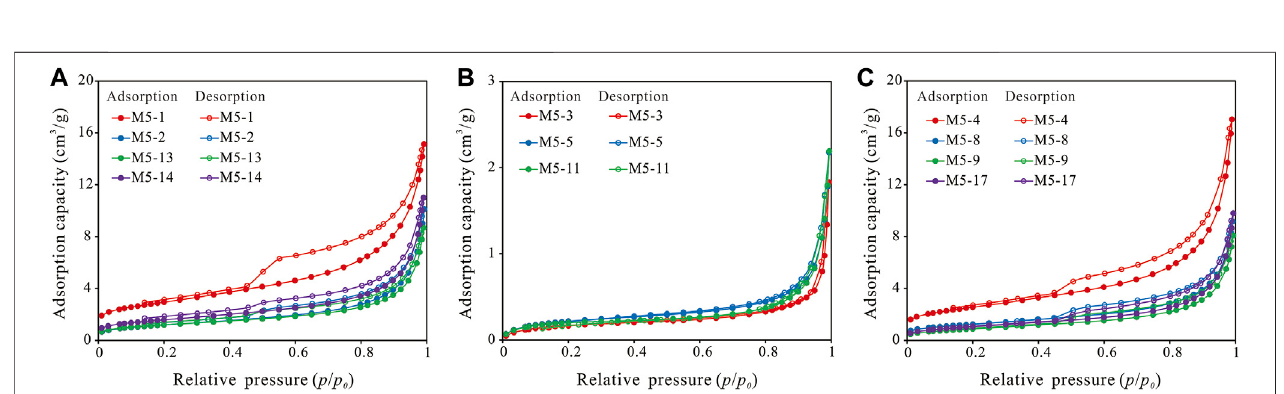
FIGURE 6 | N 2 adsorption curves of different samples. (A) Shale; (B) Coal; (C) Tight sandstone.